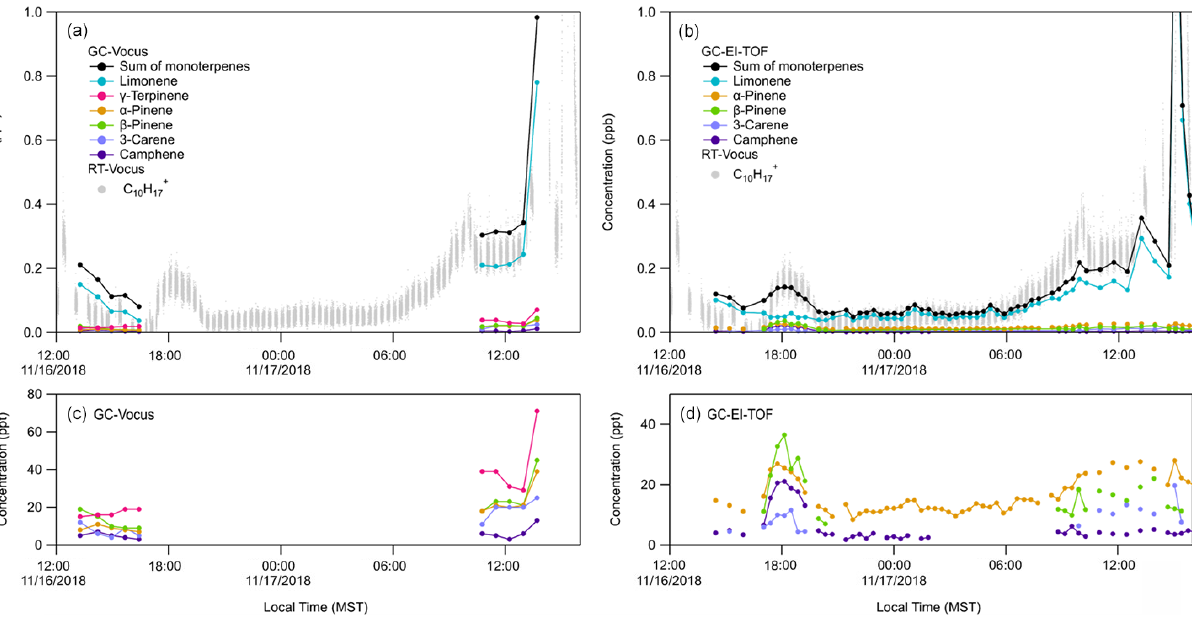
Figure 3. Quantitative speciation of RT-Vocus C 10 H + signal (grey trace) into resolved monoterpene isomers by (a) GC-Vocus (b) GC- 17 EI-TOF. Panels (c) and (d) show the same GC-Vocus and GC-EI-TOF time series as in (a) and (b) , respectively, but focused on isomers detected at lower concentrations. Absent data points in (d) are for chromatograms where the chromatographic peak area was below the limit of detection. RT-Vocus trace in (a) and (b) only shows RT-Vocus C 10 H + detected in the room (not the supply air) for a direct comparison 17 with the GC samples.